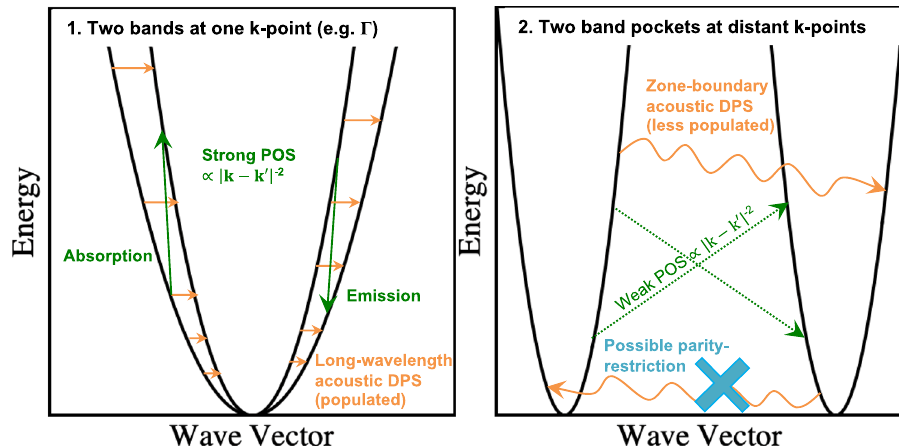
Fig. 5 Schematic of e-ph interband scattering mechanisms. They render intervalley scattering generally stronger between bands at one k-point than between bands at